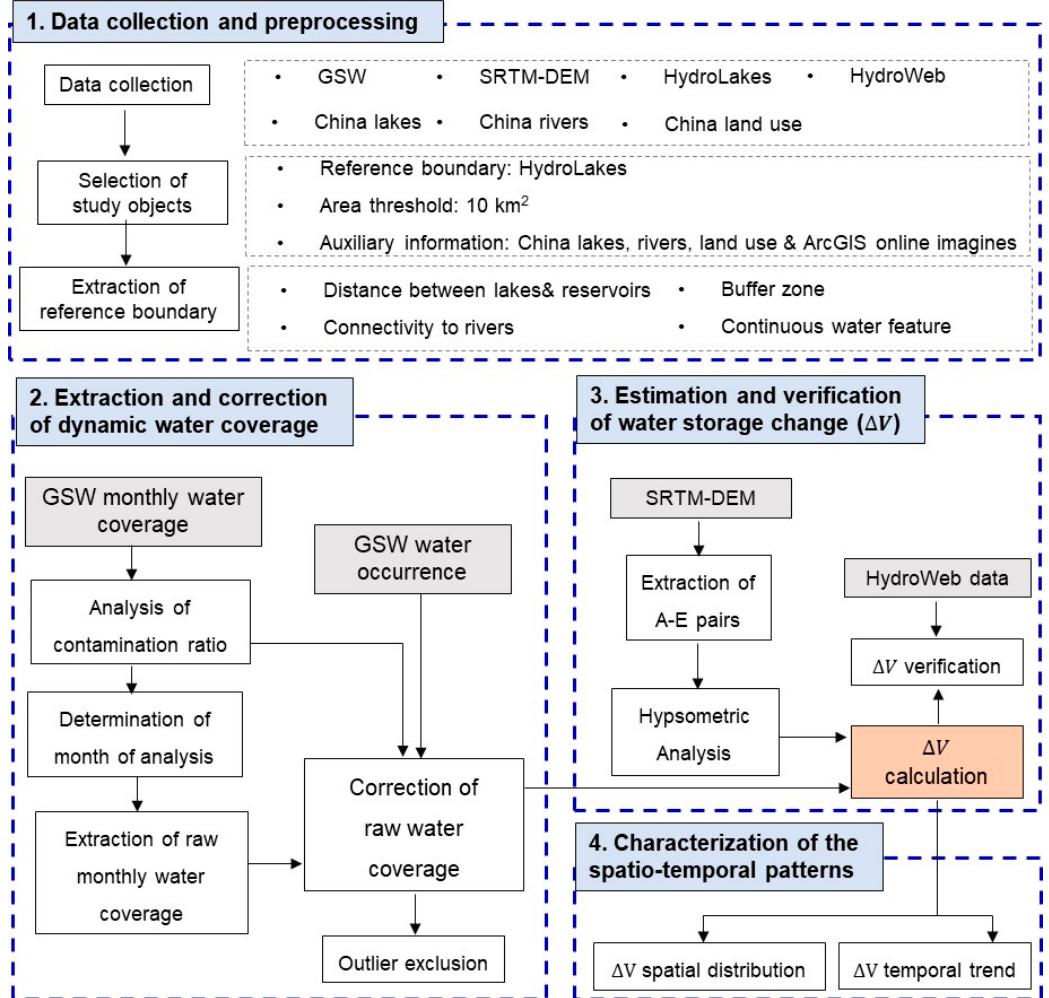
Figure 1. Flowchart of the methodology adopted to evaluate water storage change.